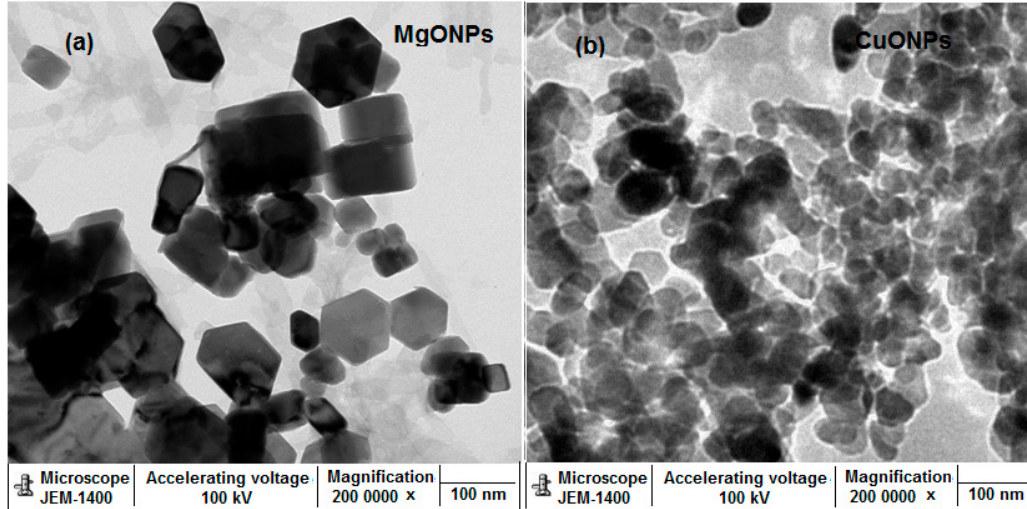
Figure 5. Transmission electron microscope (TEM) images of ( a ) MgONPs and ( b ) CuONPs at acceleration voltage 100 kV and magnification × 200,000.